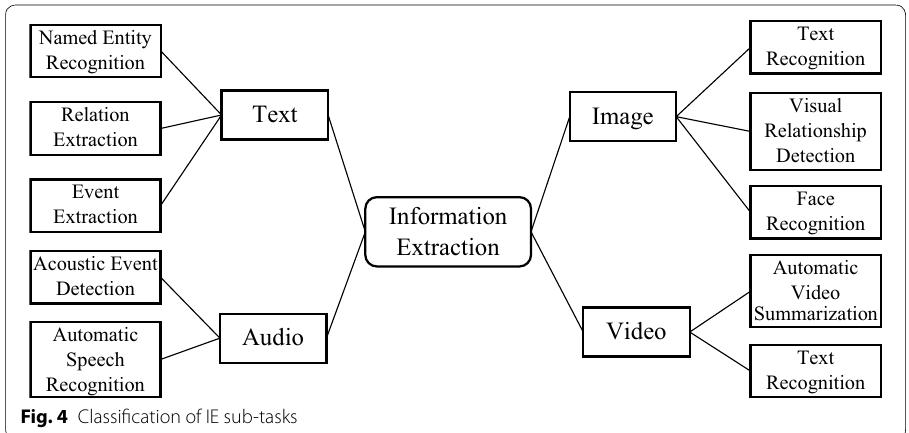
Fig. 4 Classification of IE sub-tasks